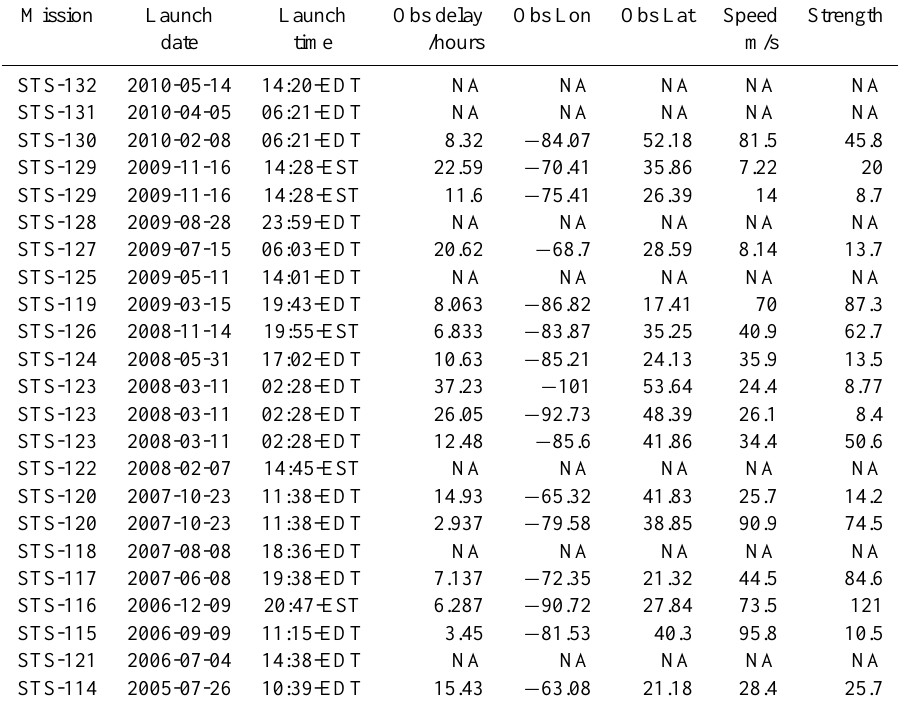
Table 1. Shuttle launches and MLS observations of them. A launch that was observed by MLS appears once for each MLS orbit on which it was observed. The “Obs delay” column is the number of hours between the launch time and the MLS observation. A launch that MLS failed to detect has NA in the last five columns. The latitude and longitude of the observation are mean values for all of the detected points on an orbit. The speed is the distance between this mean position and the assumed plume release location, divided by the observation delay. The strength is simply the sum of the amounts by which each of the individual detections on an orbit exceed 4 standard deviations.